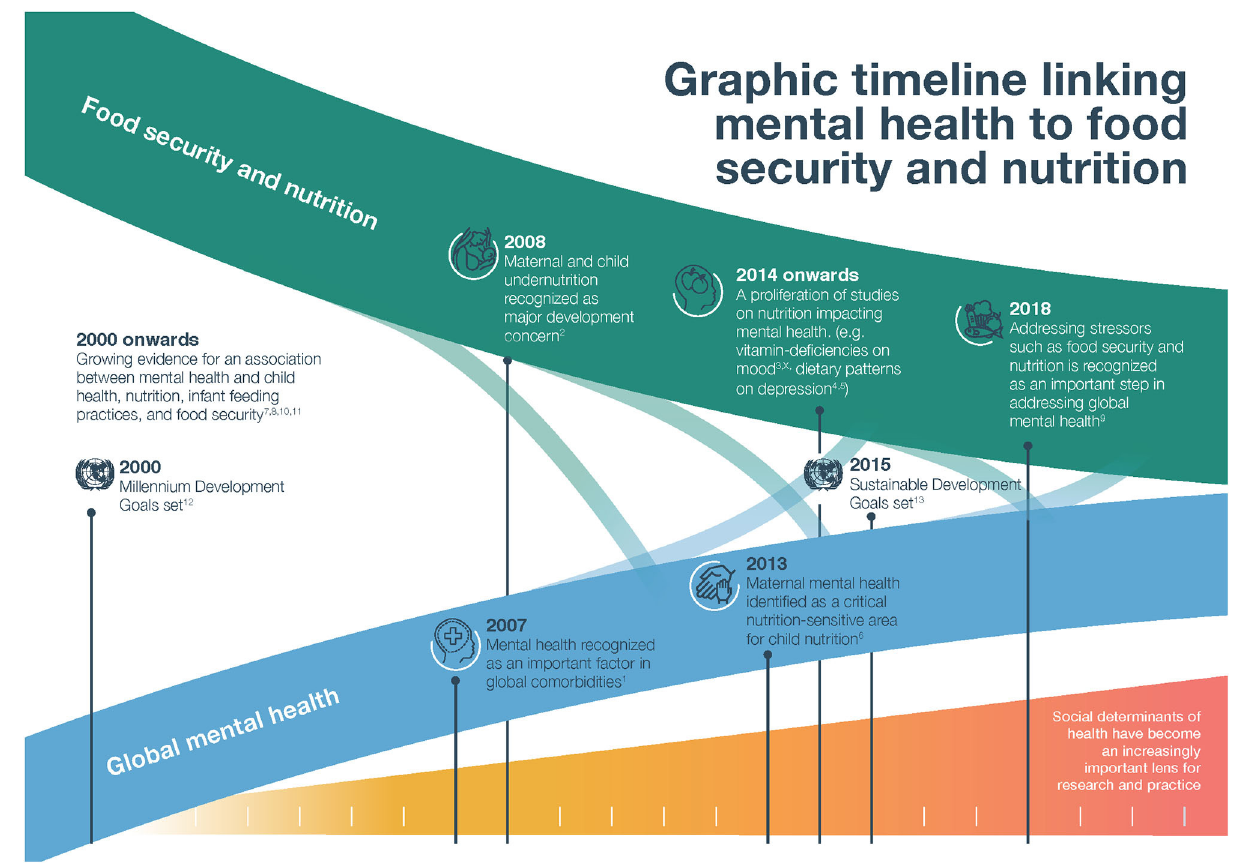
FIGURE 1 | Graphic timeline linking mental health to food security and